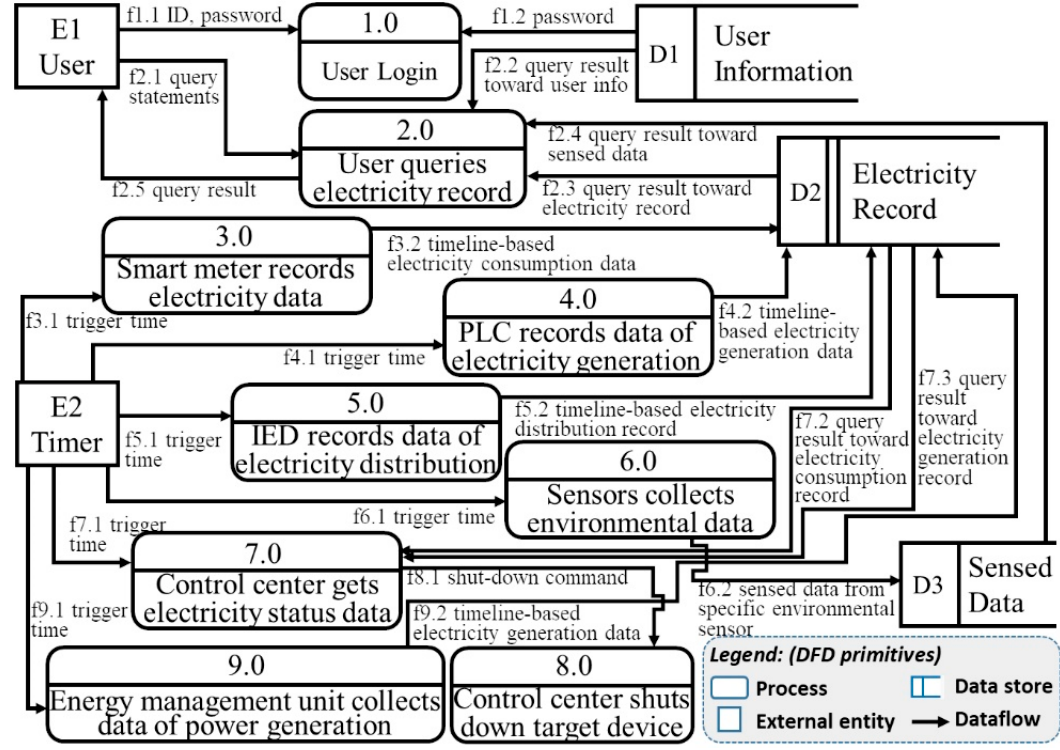
Figure 9. The DFD for the ELB practice.